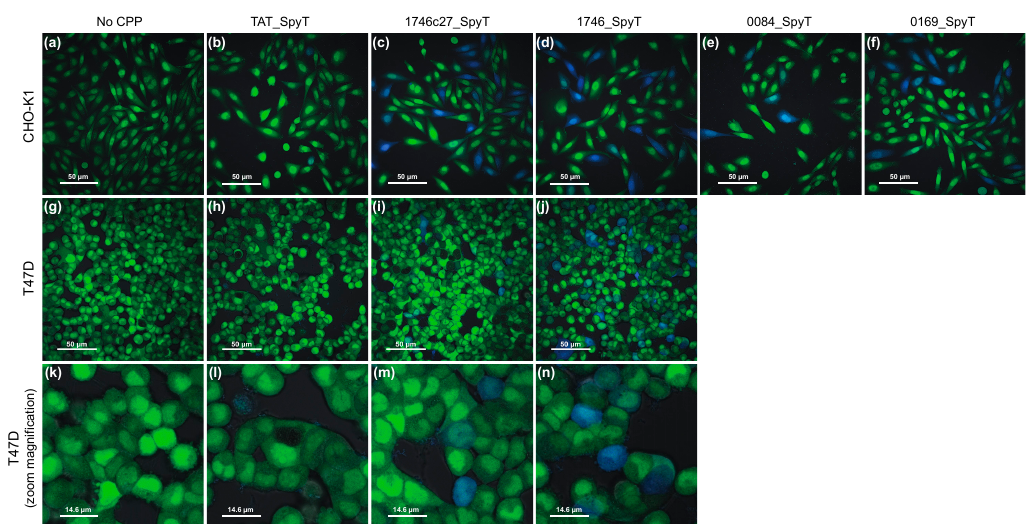
Figure 2. Live-cell confocal microscopy visualizes CPP-mediated β -lactamase internalization. The CPP-mediated uptake of CPP_SpyT/SpyC_BLA conjugates (4 µM) was visualized in CHO-K1 cells ( a – f ) and T47D cells ( g – n ). SpyC_BLA was conjugated to CPP_SpyT peptides. Unconjugated SpyC_BLA (No CPP negative controls) shows minimal evidence of internalization in both CHO-K1 and T47D cells ( a , g , k ). Conjugation with TAT_SpyT ( b , h , l ) or phylomer CPPs 1746c27_SpyT ( c , i , m ), 1746_SpyT ( d , j , n ), 0084_SpyT ( e ), and 0169_SpyT ( f ) enabled CPP-dependent uptake of SpyC_BLA. The degree of uptake is CPP-dependent and visualized by blue fluorescing cells. Bar scale is 50 µm ( a – j ) or 14.6 µm ( k – n ).